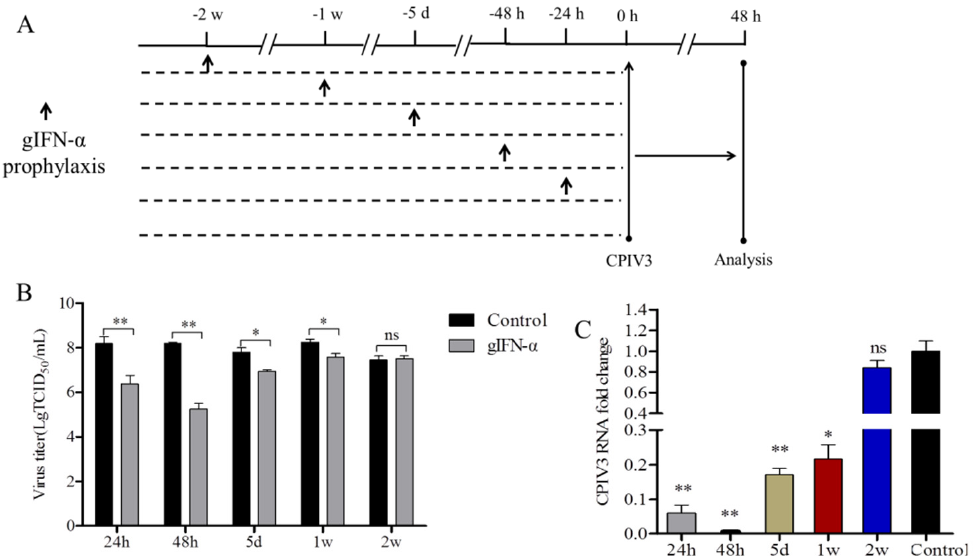
Figure 4. Duration of the antiviral activity of goat IFN- α in response to CPIV3 infection. ( A ) Ex- perimental schematic. MDBK cells were treated with goat IFN- α (1 μ g/mL), and cells were subse- quently cultured for varying lengths of time (0 h, 24 h, 48 h, 5 d, 1 w, or 2 w) prior to infection. The untreated cells were used as the negative control. MDBK cells were then infected with CPIV3 strain JS2013 at an MOI of 1, and the samples were harvested at 48 hpi. ( B ) TCID 50 results, detecting the virus titer in the culture supernatant between different groups. ( C ) The viral RNA level enabled quantification of viral shedding in the culture supernatant by RT-qPCR. *, p < 0.05, **, p <